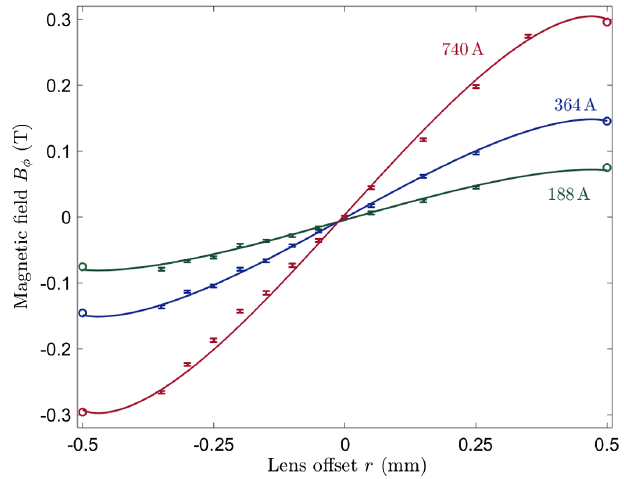
FIG. 6. Magnetic field strength in an L ¼ 7 . 5 mm APL derived from the offset scan data in Fig. 3, for r ¼ (cid:3) 0 . 5 mm, obtained from measurements of R and I 0 (circles). The sizes of the circular markers represent the rms error of the data points. The lines show the predicted behavior from the J ∼ T 3 = 2 -model.